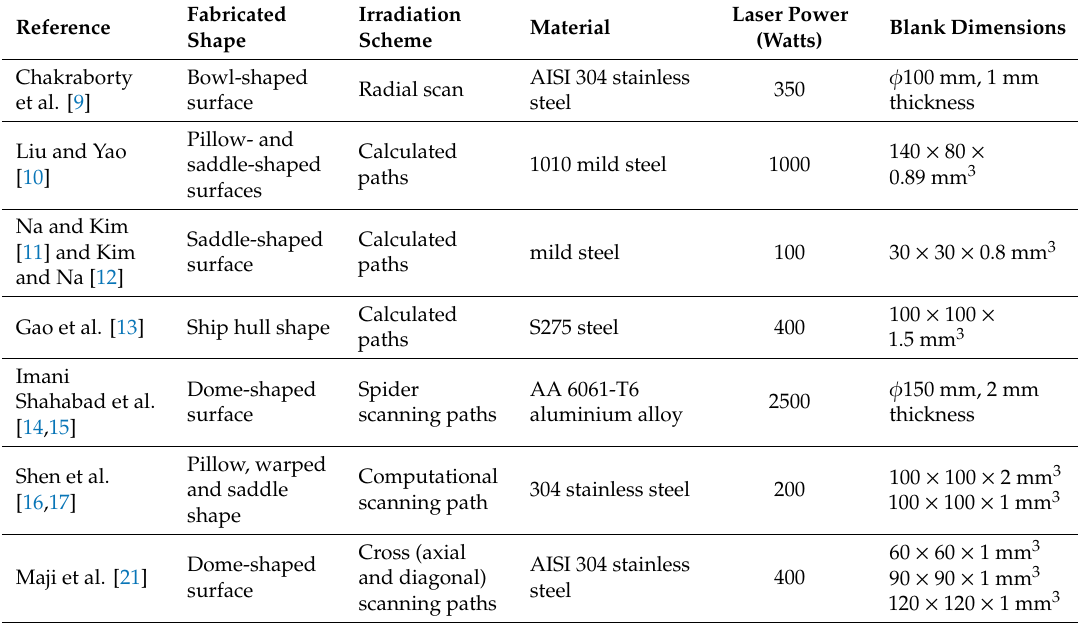
Table 1. Comparison of the irradiation schemes for the laser formation of curved sheets.